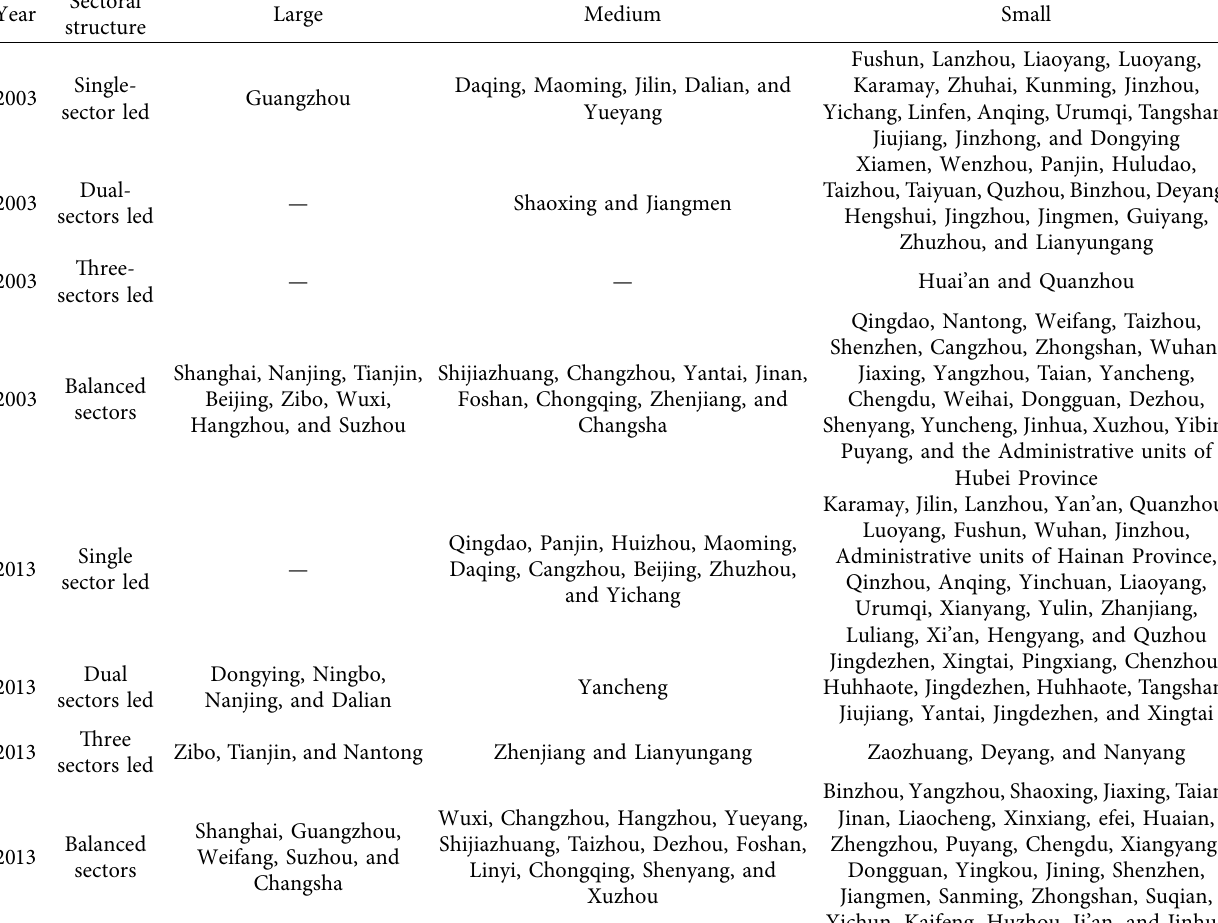
Table 2: CICs of China, 2003 and